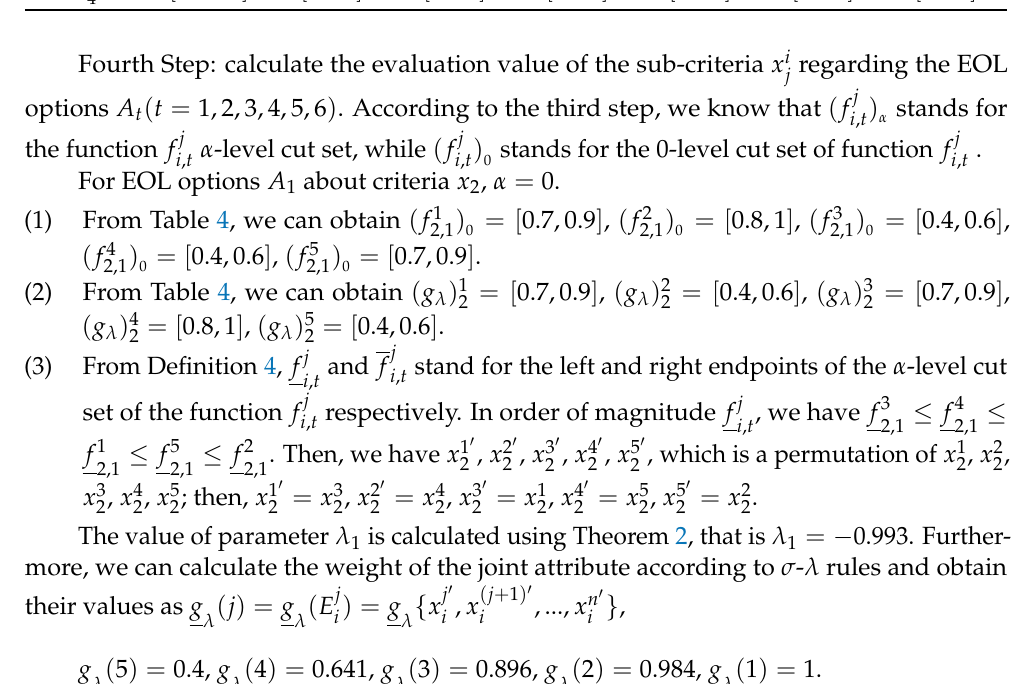
regarding the EOL j ) stands for i , t α . i , t